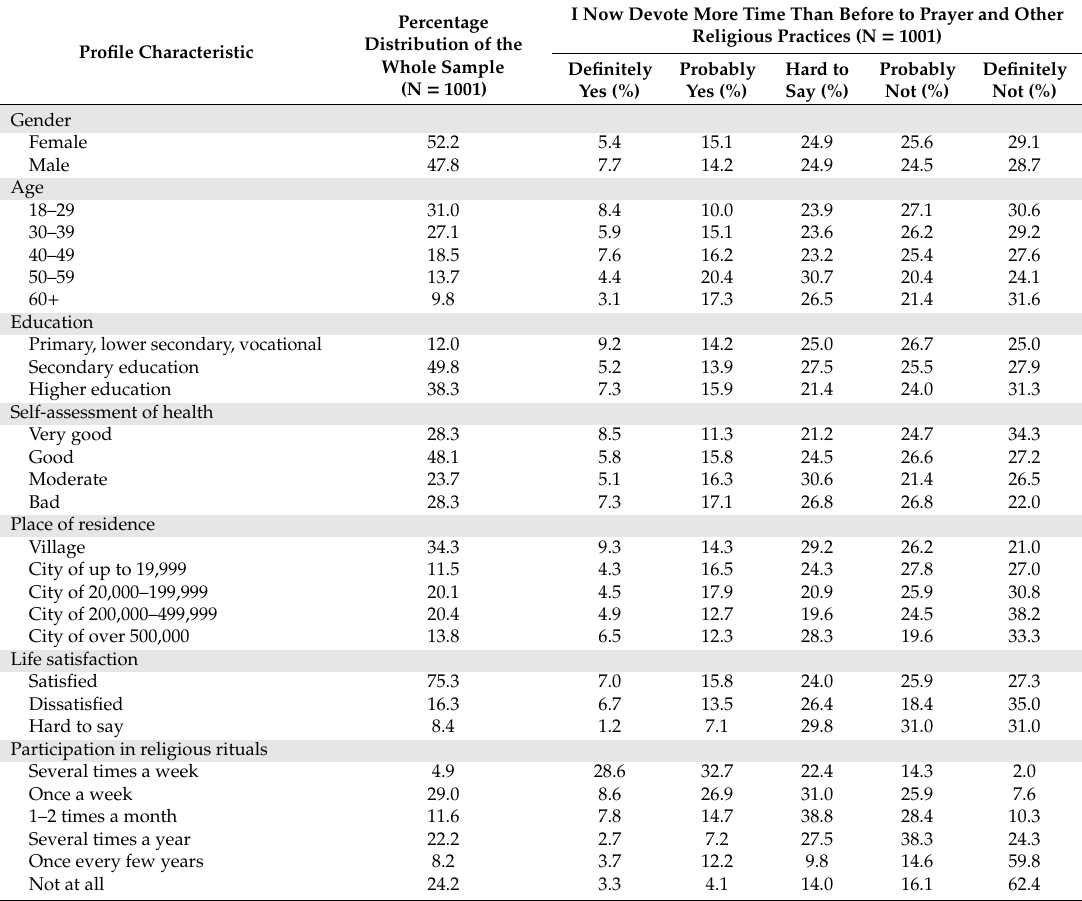
Table A1. Variables and religious involvement during the